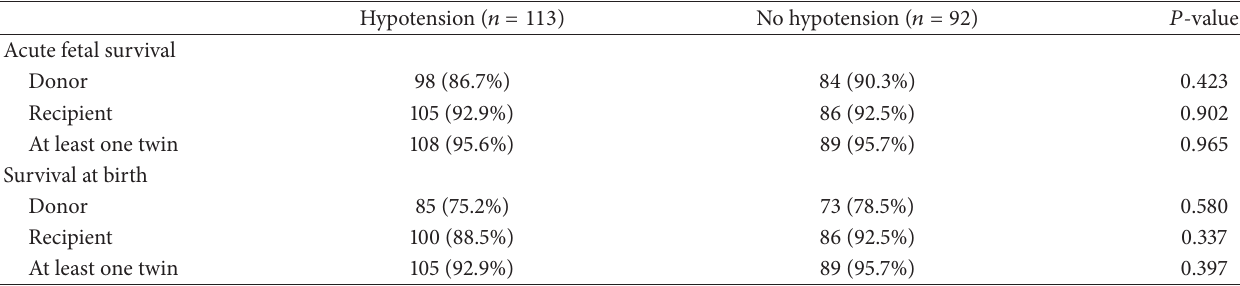
Table 4: Fetal survival outcomes of patients with and without intraoperative hypotension. The acute survival rate of the recipient and donor twins was determined by ultrasound or fetal echocardiogram performed on days 3–5 after fetoscopic surgery. The survival rate at birth of the recipient twin and donor twins was defined as live birth at